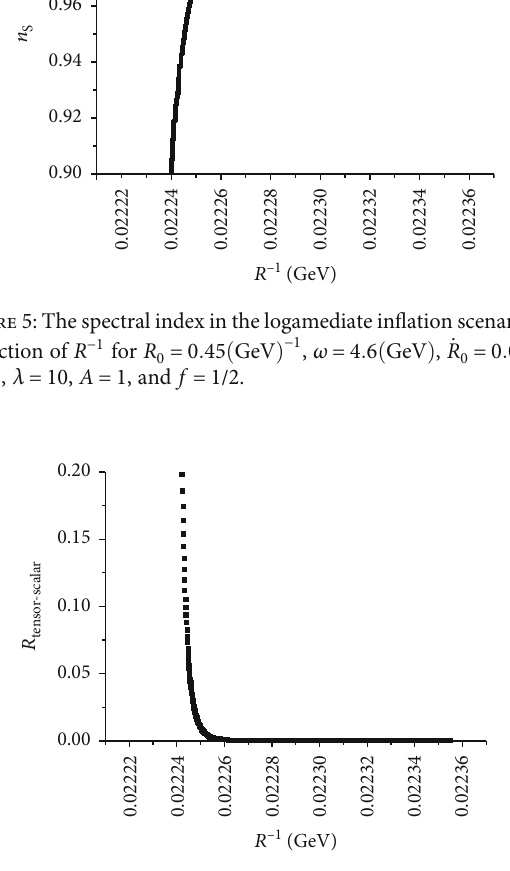
= 0 : 45 ð GeV Þ − 1 , ω = 4 : 6 ð GeV Þ , 0